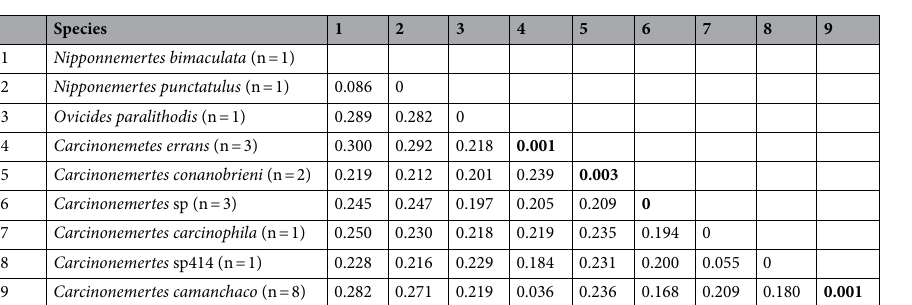
Figure 3. Phylogenetic tree based on the cox1 gene for Carcinonemertes spp. from different host species, inferred using Bayesian inference (BI) and Maximum Likelihood (ML) analyses. Numbers near internal nodes denote posterior probabilities or bootstrap values from the BI and ML phylogenetic analyses (BI/ML), respectively. Sequences for Nipponnemertes bimaculata and N. punctatulus were used as outgroups. SEP South eastern Pacific, NWA North western Pacific, SWA South western Atlantic, NWP North western Pacific.